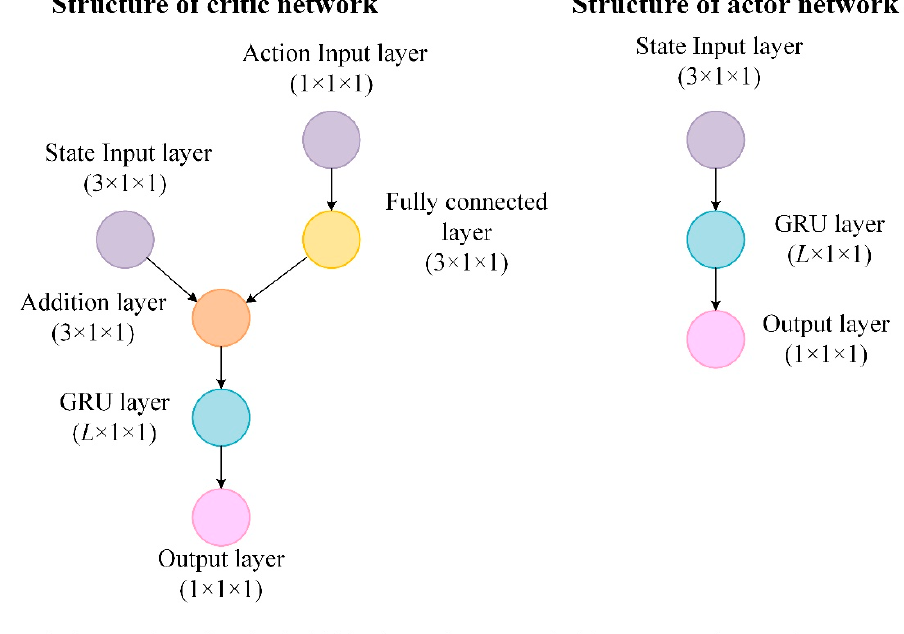
Figure 6. Structures of critic and actor networks for the liquid level controller.